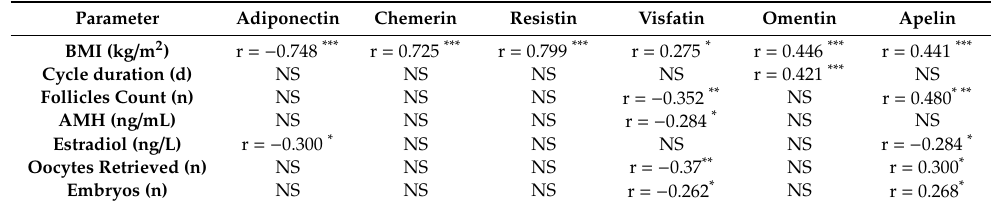
Table 2. Correlations between follicular fluid concentration of adipokines and clinical parameters, hormonal data, and in vitro fertilization procedure outcomes ( n =